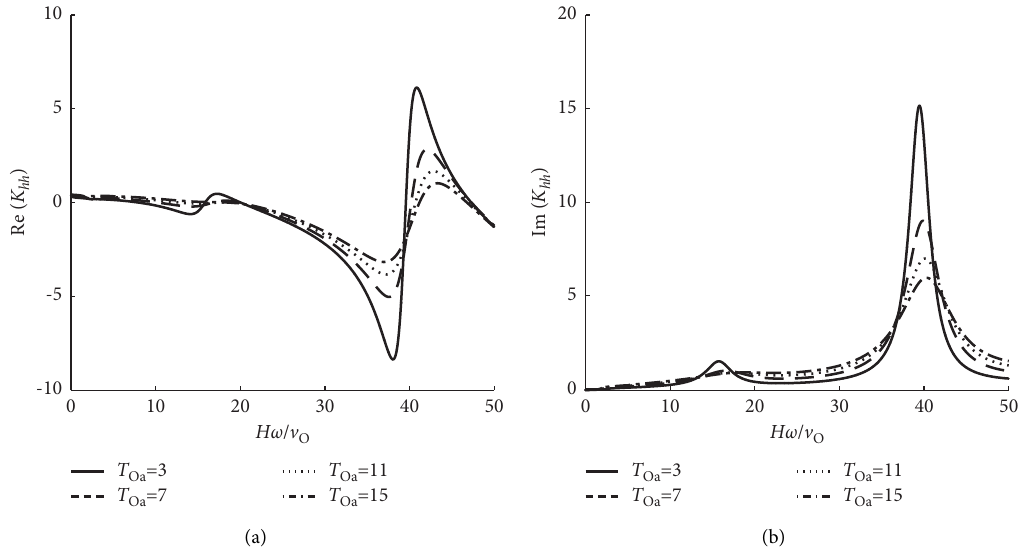
Figure 14: The horizontal dynamic impedance curves of pipe pile under different model parameters ( T dynamic impedance. (b) Imaginary part of horizontal dynamic